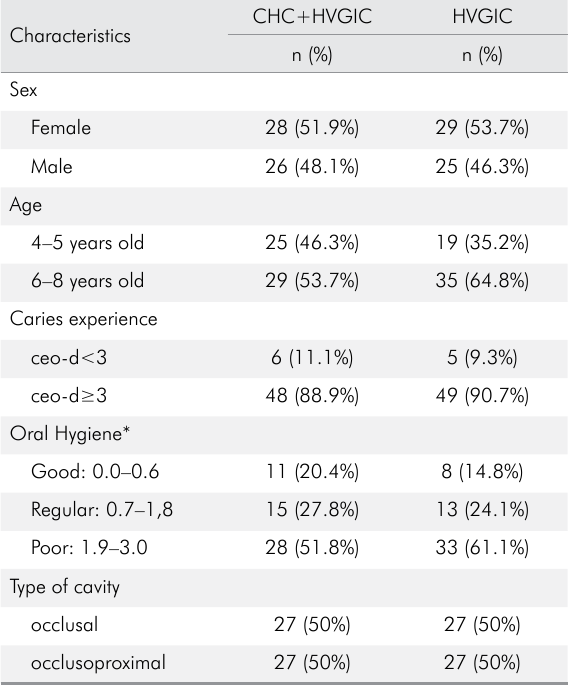
Table 1. Baseline characteristics of participants included into the